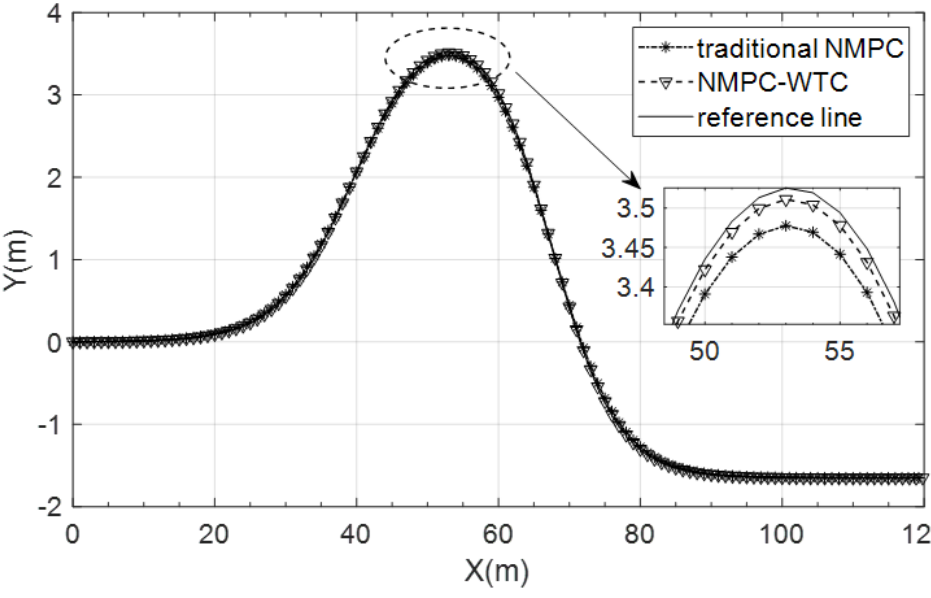
Figure 5. Path tracking in double line shifting scenario.